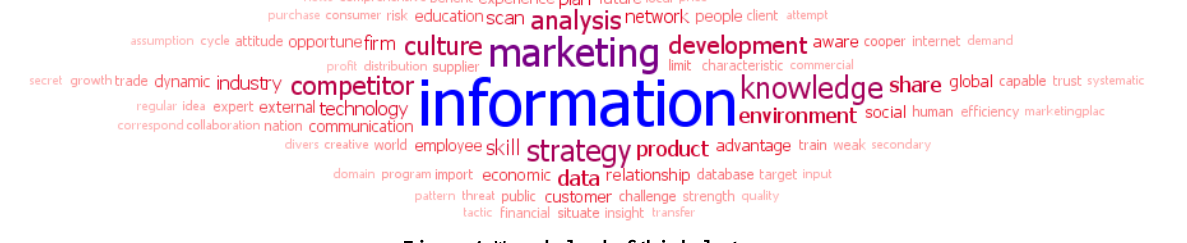
Figure 4. Word cloud of third cluster.